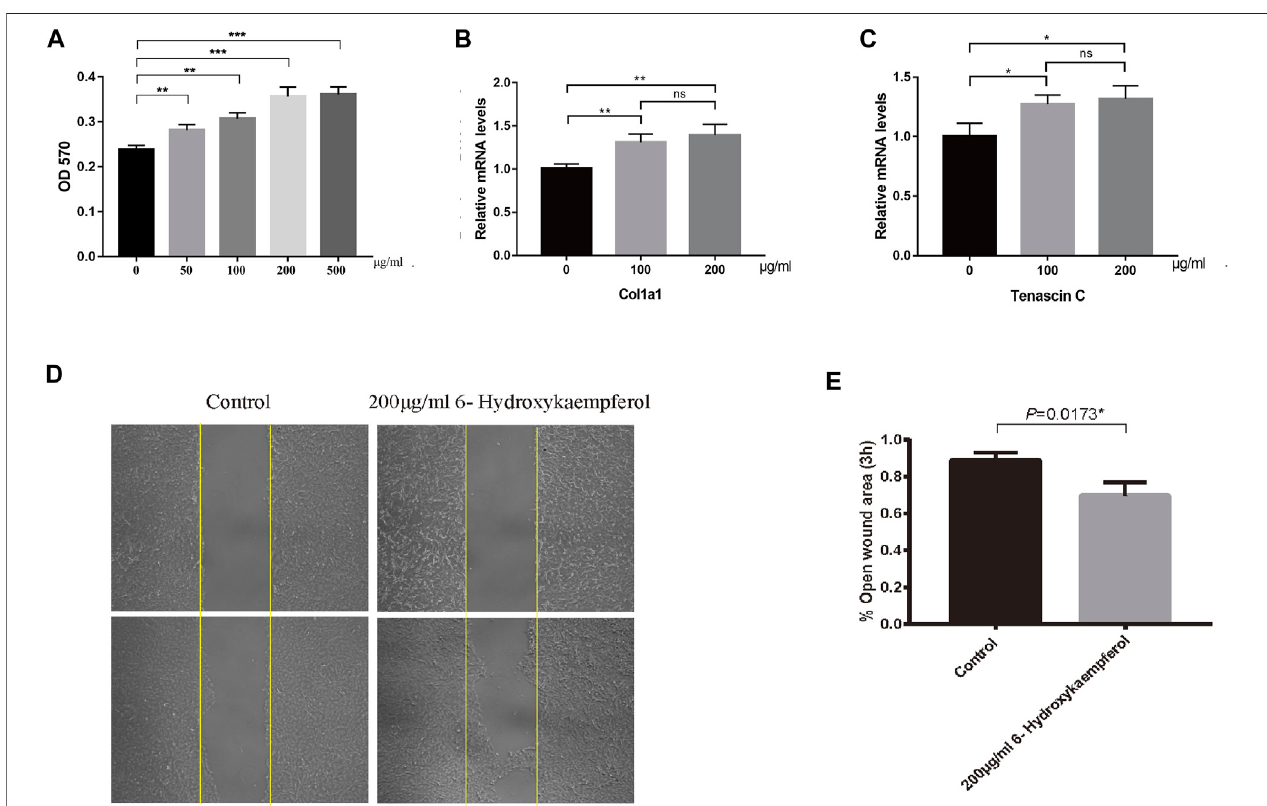
FIGURE 4| 6-Hydroxykaempferolwas evaluated as a fi broblast proliferator. (A) Tendon fi broblasts(3 × 10 3 ) were seeded in each well ofa 96-well culture plate for MTTassay.Quanti fi cationoftheRNAlevelsfor (B) Col1a1 and (C) TNC wasachievedusingquantitativereal-time PCR. (D) Scratchwoundassaywasperformedtotest the migration of tendon fi broblasts. (E) Percentage of the open wound